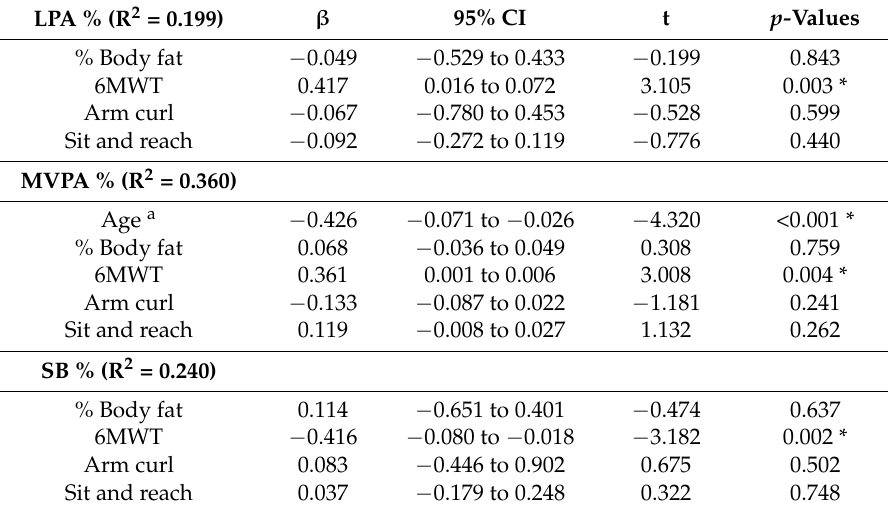
Table 2. Contribution of physical fitness variables in explaining variance of physical activity and sedentary